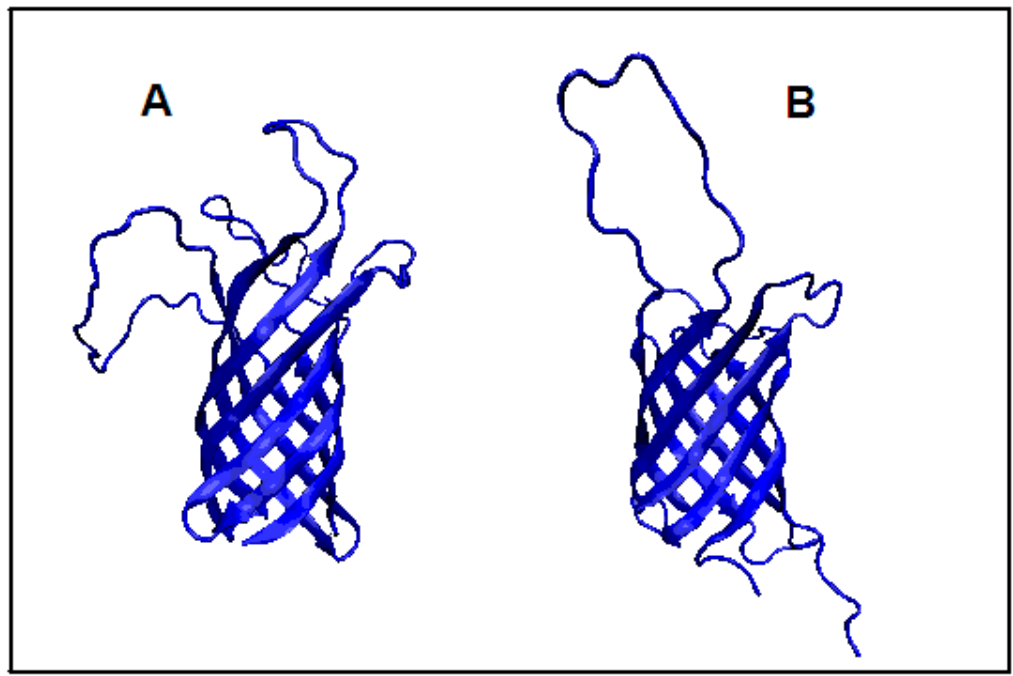
Figure 3. 3D structure presentation revealing a different pattern of loops in proteins showing a distribution consistent with the distribution corresponding to the presence of a hydrophobic core. ( A ) 2LHF and ( B ) 2JMM.